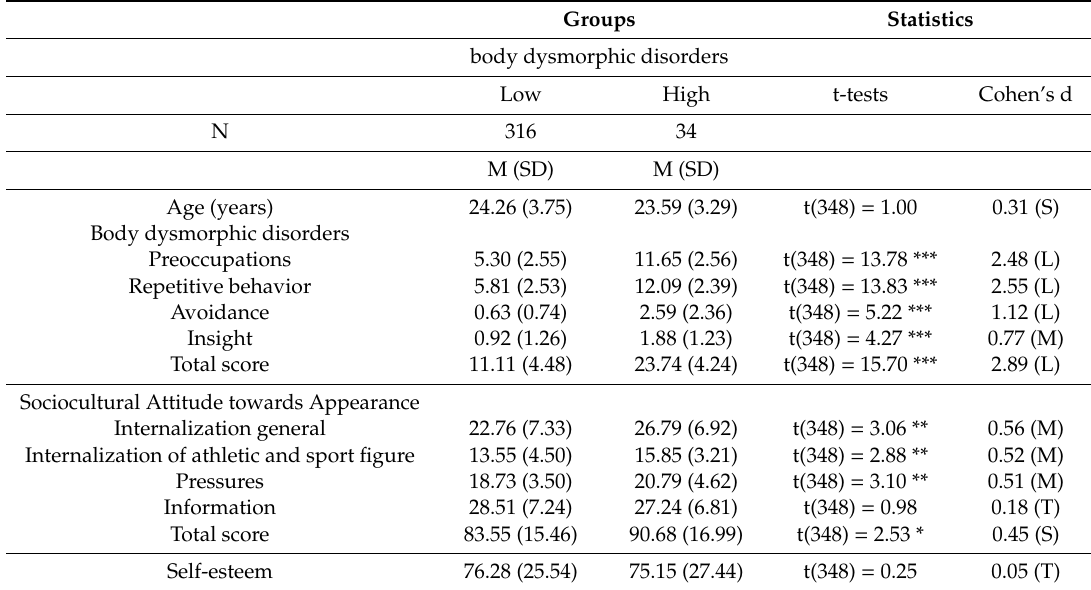
Table 2. Descriptive and inferential statistical indices of age, body dysmorphic disorders (experts’ ratings) and sociocultural attitudes towards appearance, and self-esteem, separately for individuals with low body dysmorphic disorders and high body dysmorphic